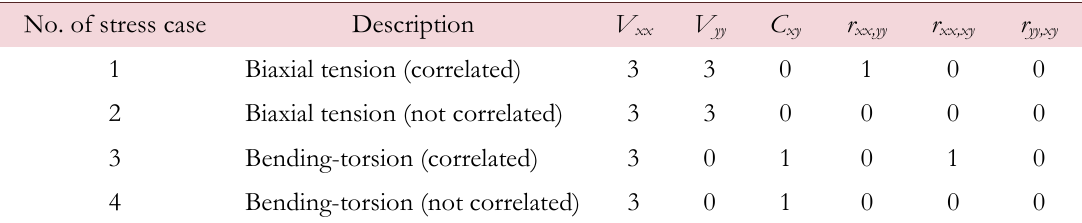
Table 2: Variance and correlation degree characterizing the biaxial stress states considered in numerical